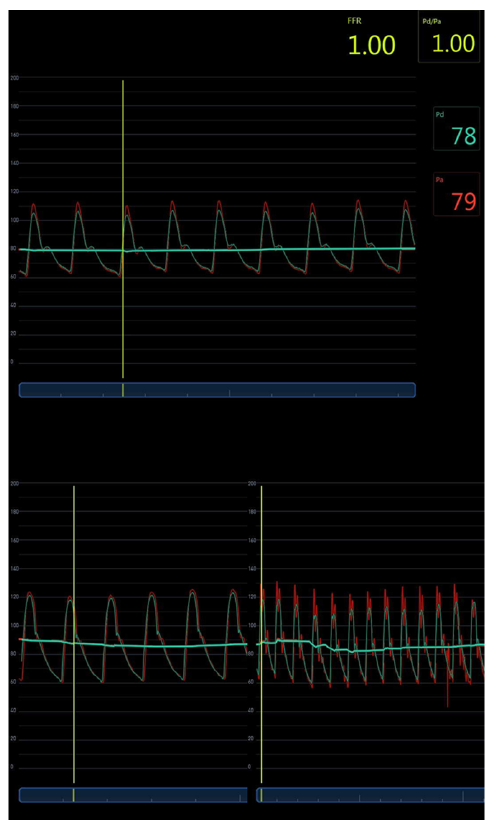
Figure 4. Screenshots of the recordings with the iLab (Boston Scientific) of the FFR pressure wire (Pd) in blue and the fluid ‐ filled pressure (Pa) in red in 3 different patients. The pressure wire was equalized in the guiding catheter left in the ascending aorta, so that its mean value equals the mean fluid ‐ filled pressure, resulting in an FFR value of 1. The lower right panel demonstrates a clearly underdamped system with many oscillation artefacts, while the timing of the feet of the Pa and Pd pressure waves is the same for these patients.